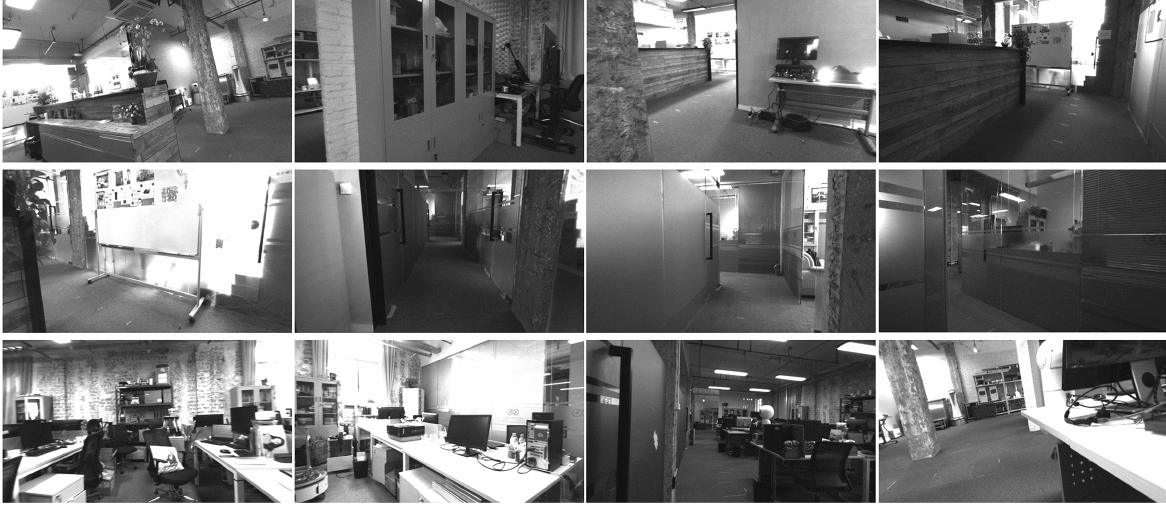
Figure 7. Samples of the sequence captured in an office.